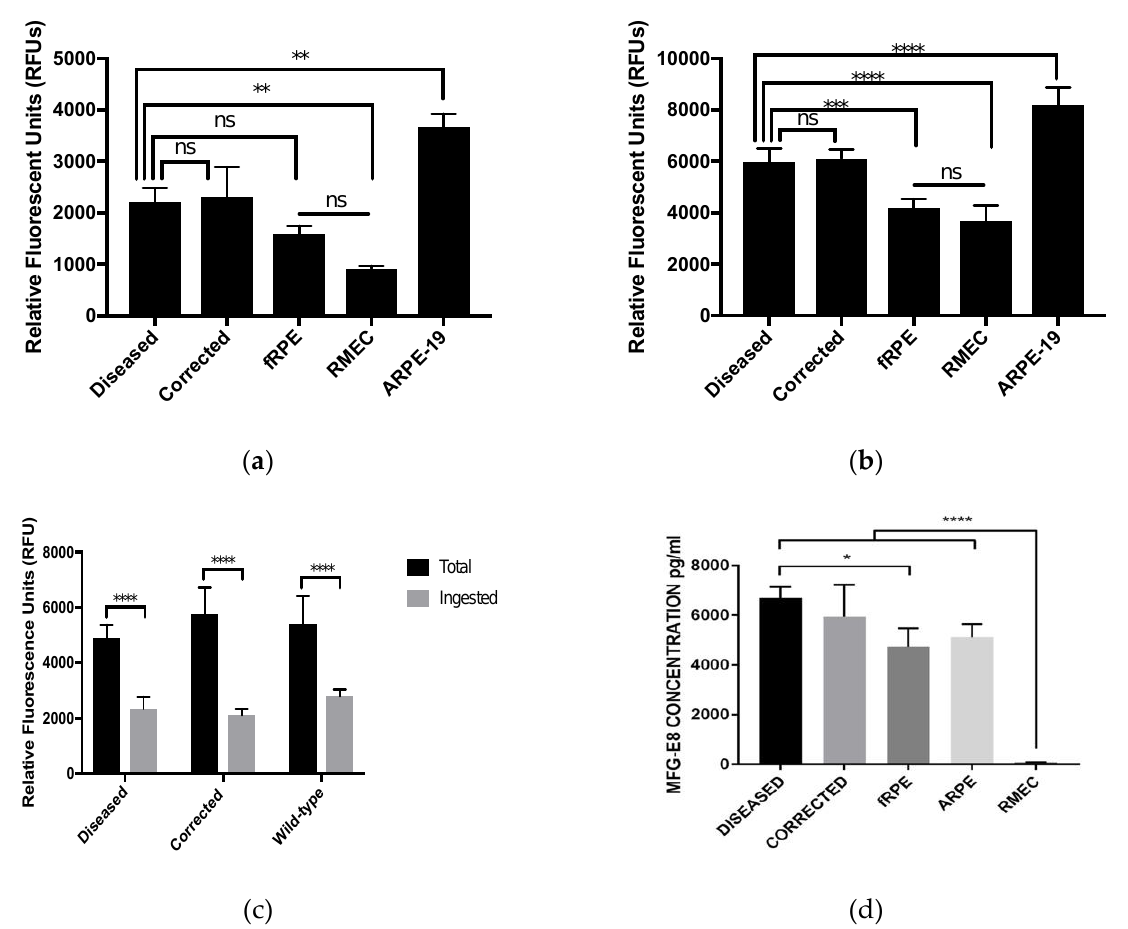
Figure 5. Phagocytosis of photoreceptor outer segments at passage 3 on day 30: ( a ) no significant difference in ingested outer segments between diseased and corrected RPE cells, diseased RPE cells ingested significantly more outer segments than the negative control (RMEC); ( b ) no significant difference in total (bound and ingested) outer segments between diseased and corrected RPE cells, and total outer segments significantly higher than the positive and negative control (fRPE cells and RMECs, respectively). ns equals not significant, N = 3, *** p < 0.0005, ** p < 0.005; ( c ) patient-derived diseased and corrected RPE cells compared to wild-type RPE cells (H9, UCSF4, and MyCell) revealed no significant differences between lines. **** p < 0.0005; ( d ) RMECs secreted significantly less RPE-specific MFG-E8. N = 3, * p < 0.05. RMECs, retinal microvascular endothelial cells; fRPE, fetal RPE; ARPE-19, immortalized RPE cells.